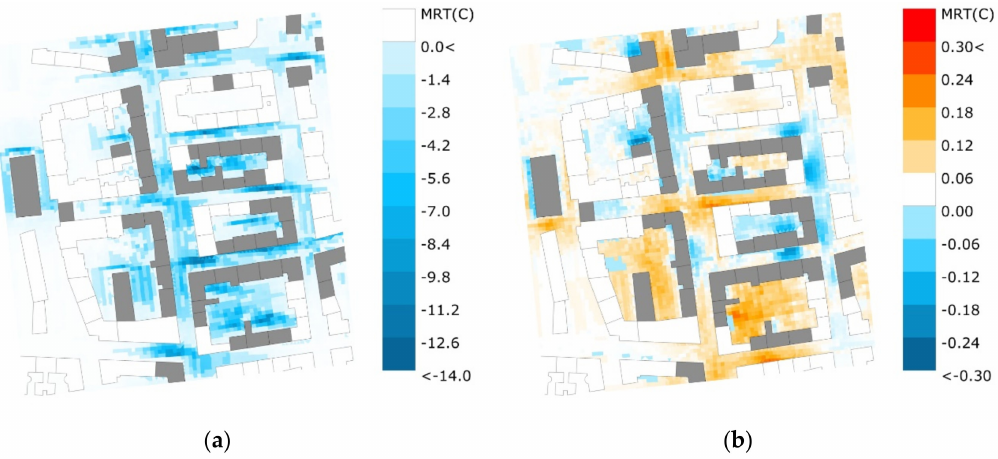
Figure 9. MRT di ff erence maps generated for a 12-hour period at ground level: ( a ) day-time; ( b )